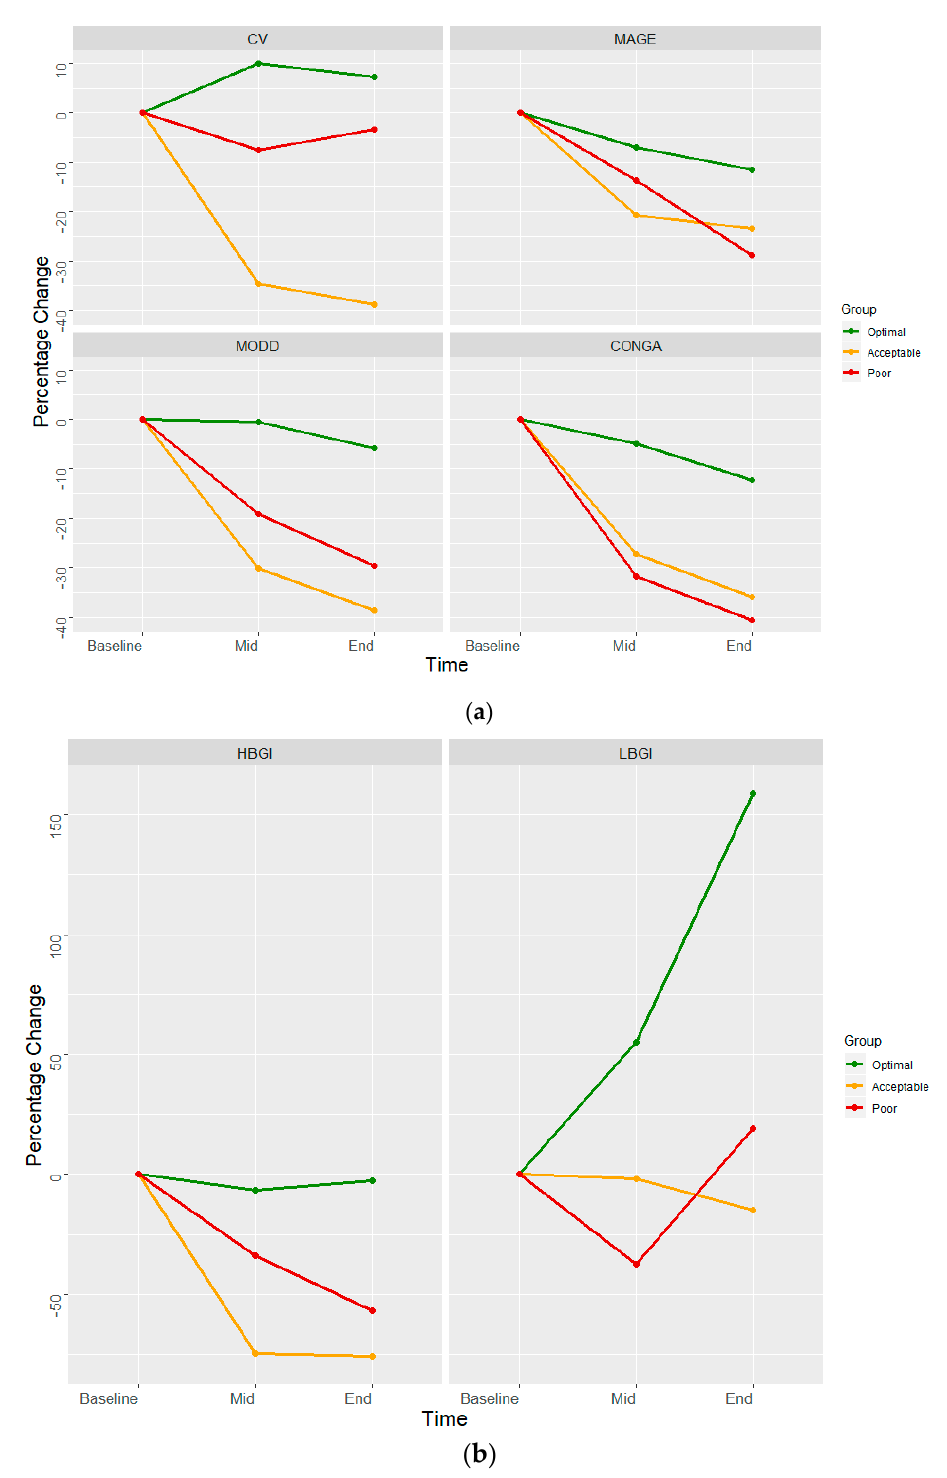
Figure 1. Percentage change in glycemic variability indices. ( a ) coefficient of variation (CV), mean amplitude of glycemic excursion (MAGE), mean of daily difference for inter-day variation (MODD), and continuous overlapping net glycemic action (CONGA). ( b ) High blood glucose index (HBGI) and low blood glucose index (LBGI) from baseline among various glycemic control categories (risk plot).